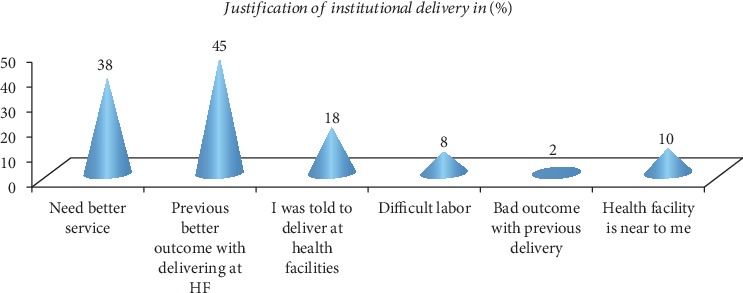
Justifications given by mothers who utilized institutional delivery in Chelia District (March 2018).